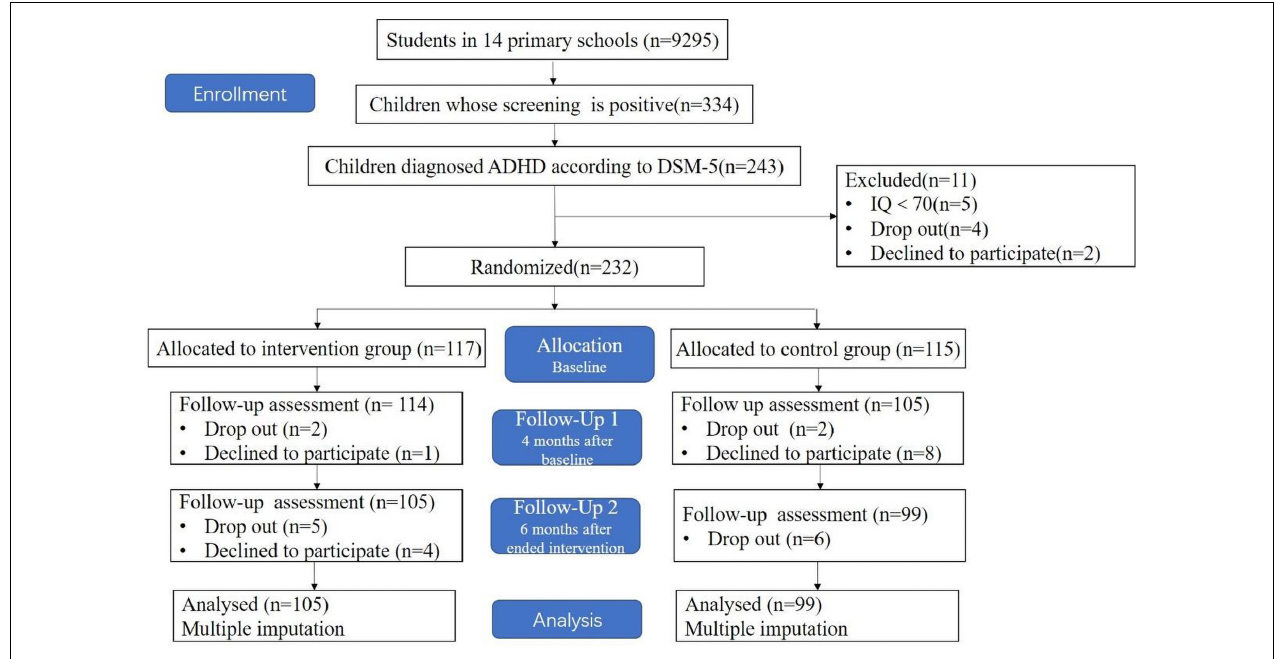
FIGURE 1 | Flow diagram of participant enrollment and trial